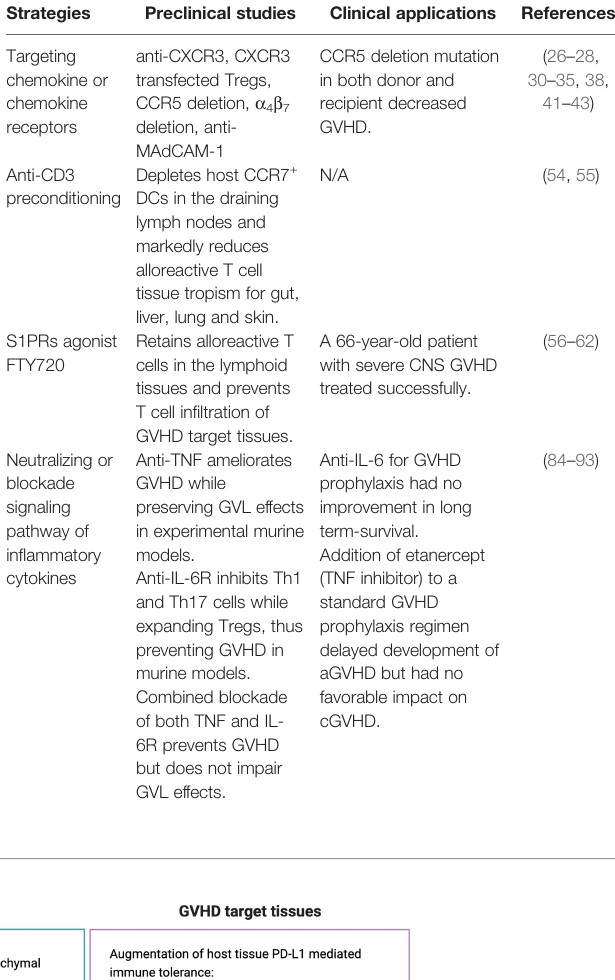
TABLE 1 | Approaches that prevent alloreactive T cell in fi ltration into GVHD target